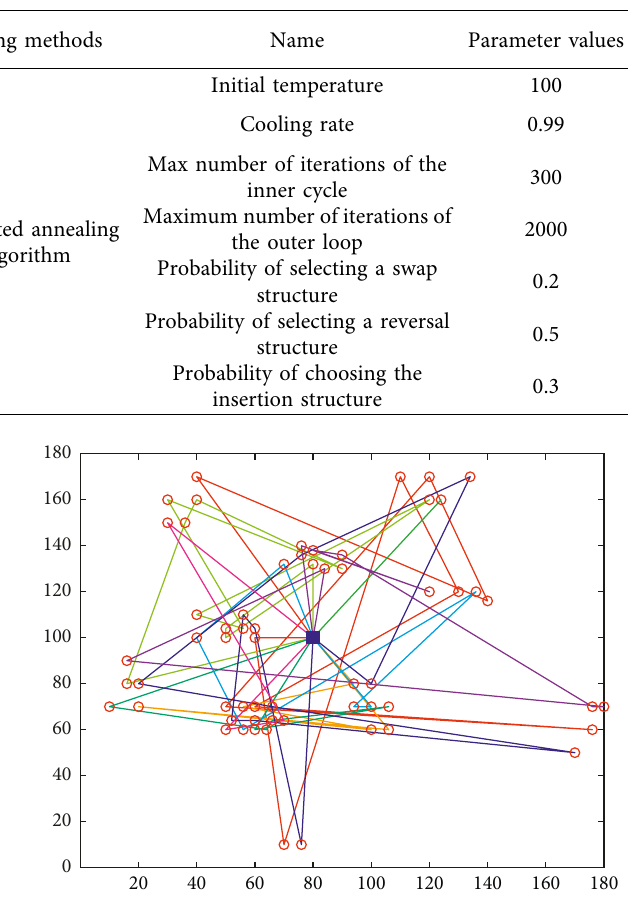
Table 3: Algorithm parameter settings.